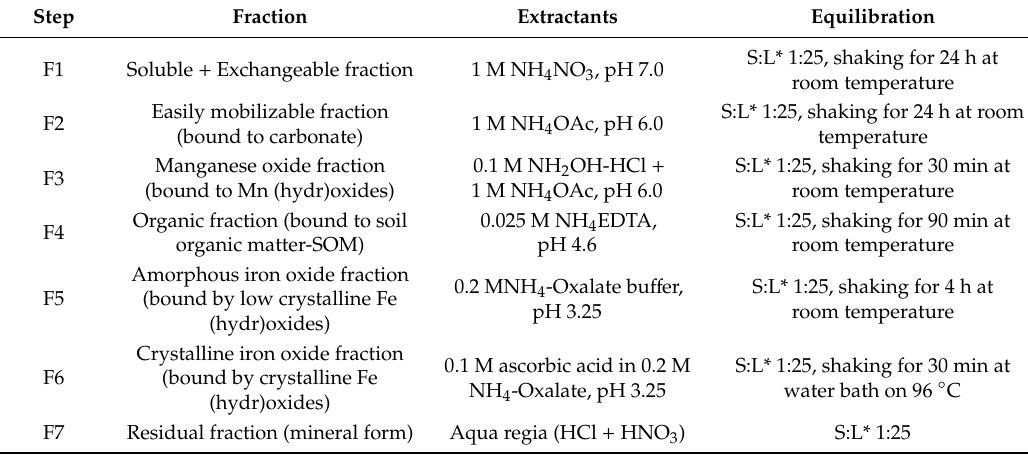
Table 1. Sequential extraction